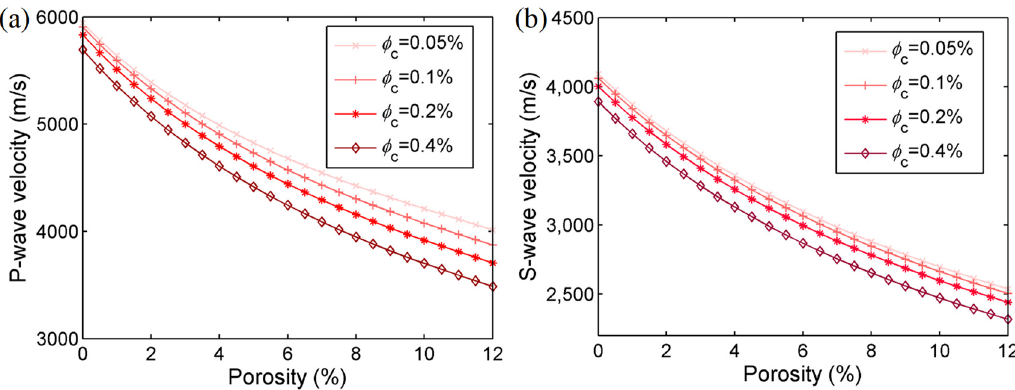
Figure 7. Effect of the total and microcrack porosities on the P-wave ( a ) and S-wave ( b ) velocities.